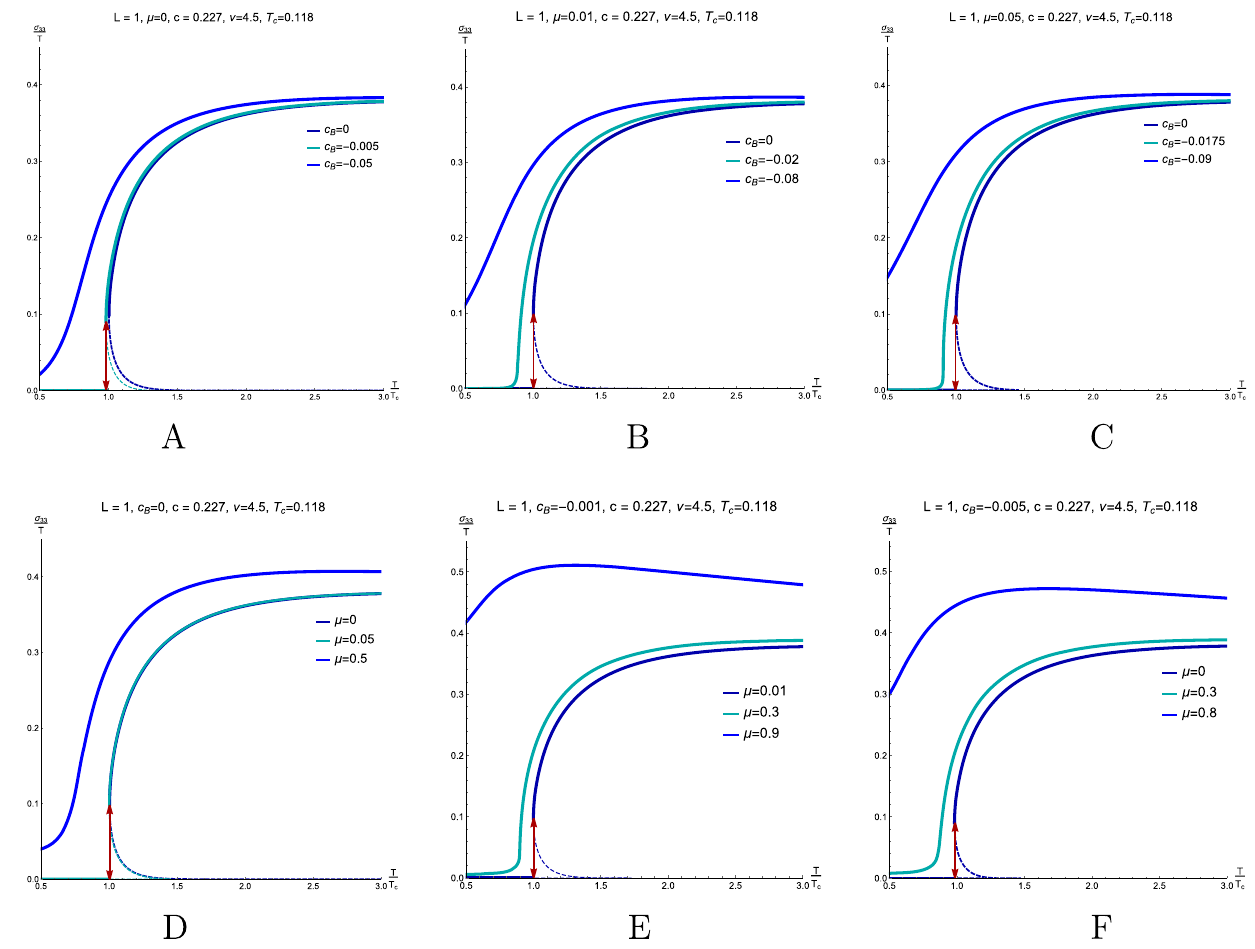
Fig. 10 The dependence of σ 33 / T on the normalized temperature T / T c for different values of magnetic field’s parameter c B and μ = 0 ( A ), μ = 0 . 01 ( B ) and μ = 0 . 05 ( C ), and for different values of chem-